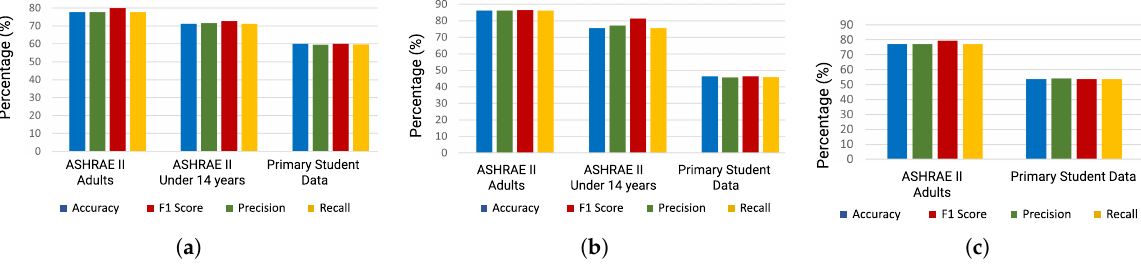
Figure 9. Prediction performance for adults and primary school students; ( a ) Thermal Sensation Vote; ( b ) Thermal Preference Vote; and ( c ) Thermal Comfort